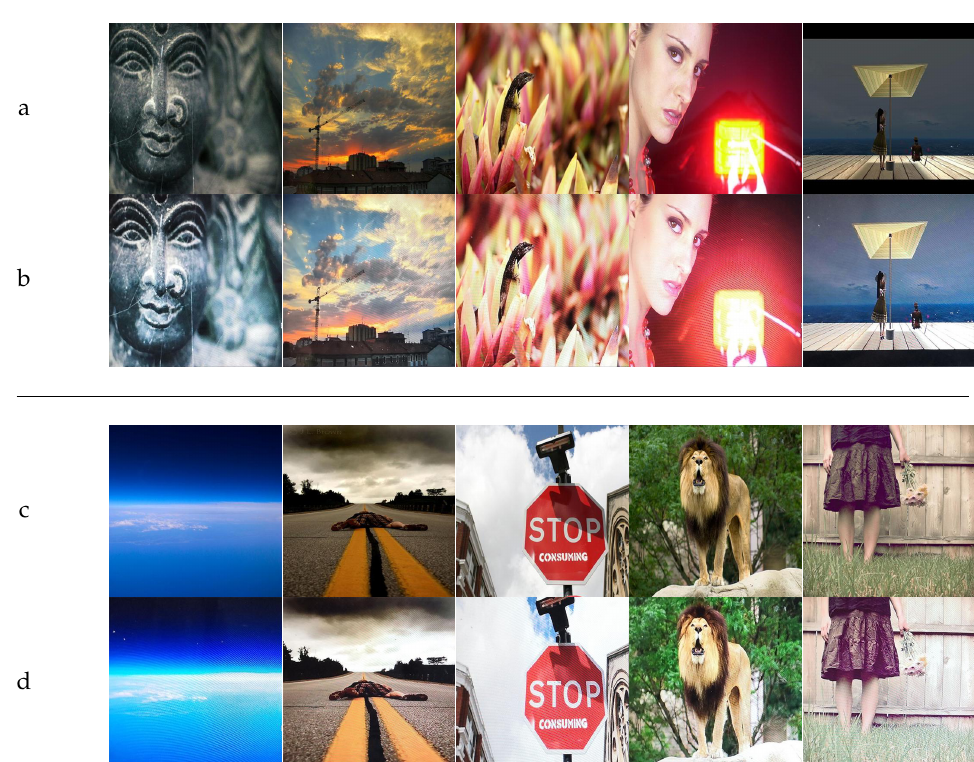
Figure 6. Moiré pattern test results from COCO 2014 dataset by the fine-tune network. ( a , c ) pure images; ( b , d ) images (512 × 512) with moiré pattern.